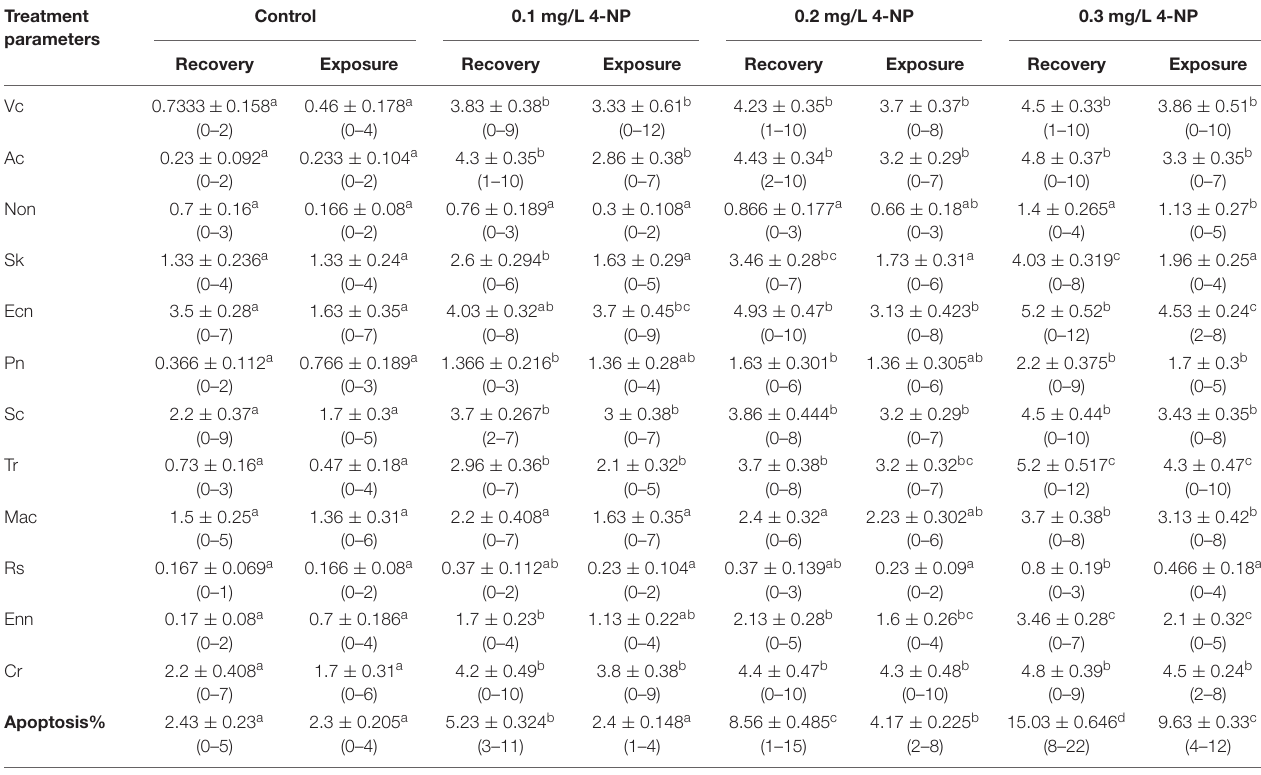
TABLE 4 | Erythrocytes morphological alterations, nuclear abnormalities, and apoptosis (mean ± SE) in juvenile African catfish ( Clarias gariepinus) exposed to 0.1, 0.2, and 0.3 mg/L 4-NP for 15 days and recovery for 15 days ( n = 3). Treatment